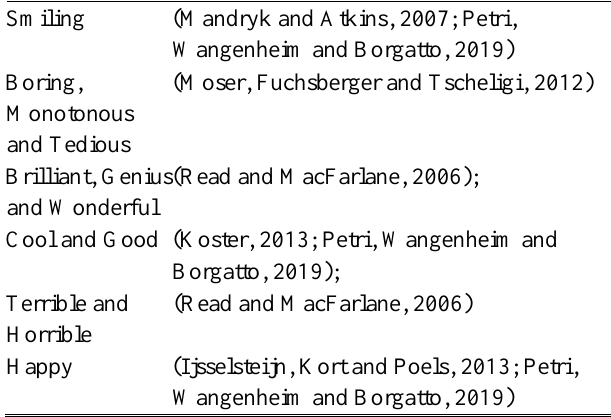
Table 7. Perceptions or reactions related to